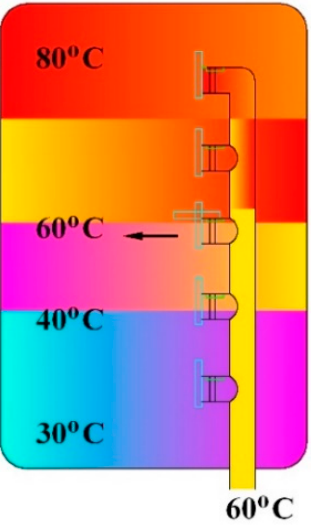
Figure 10. Stratification thermal energy storage in a water